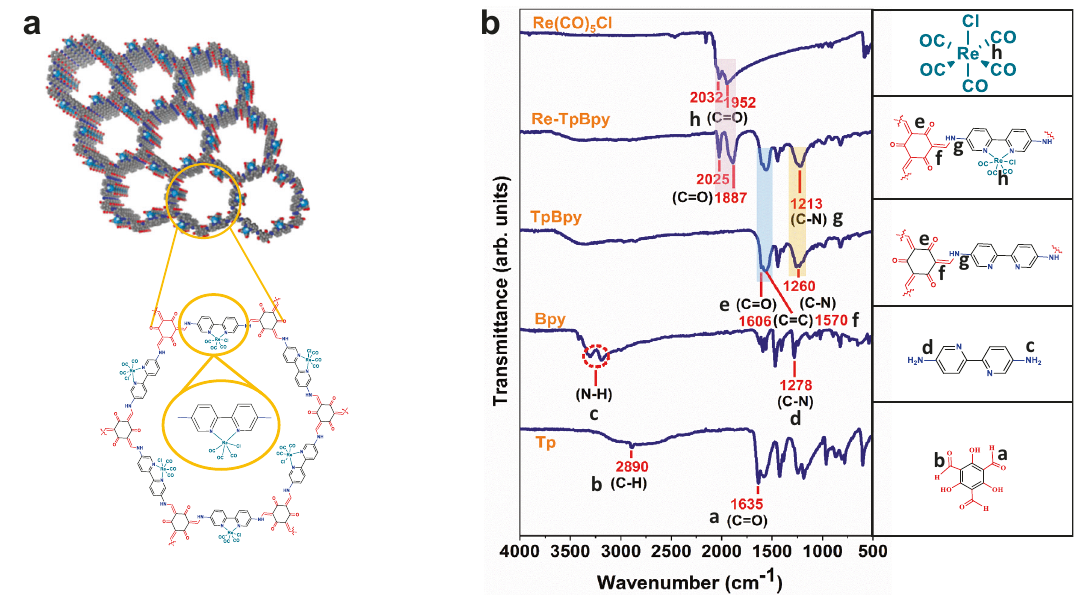
Fig. 1 Chemical structures of the samples. ( a ) Schematic structure of the Re-TpBpy. ( b ) FT-IR spectra of TpBpy, Re-TpBpy and their starting materials with the right panel showing the molecular structure of the corresponding unit, where the bonds of a: C = O, b: C – H; c: N – H; d: C – N; e: C = O; f: C = C, and g: C – N are highlighted. Source data are provided as a Source data fi le.